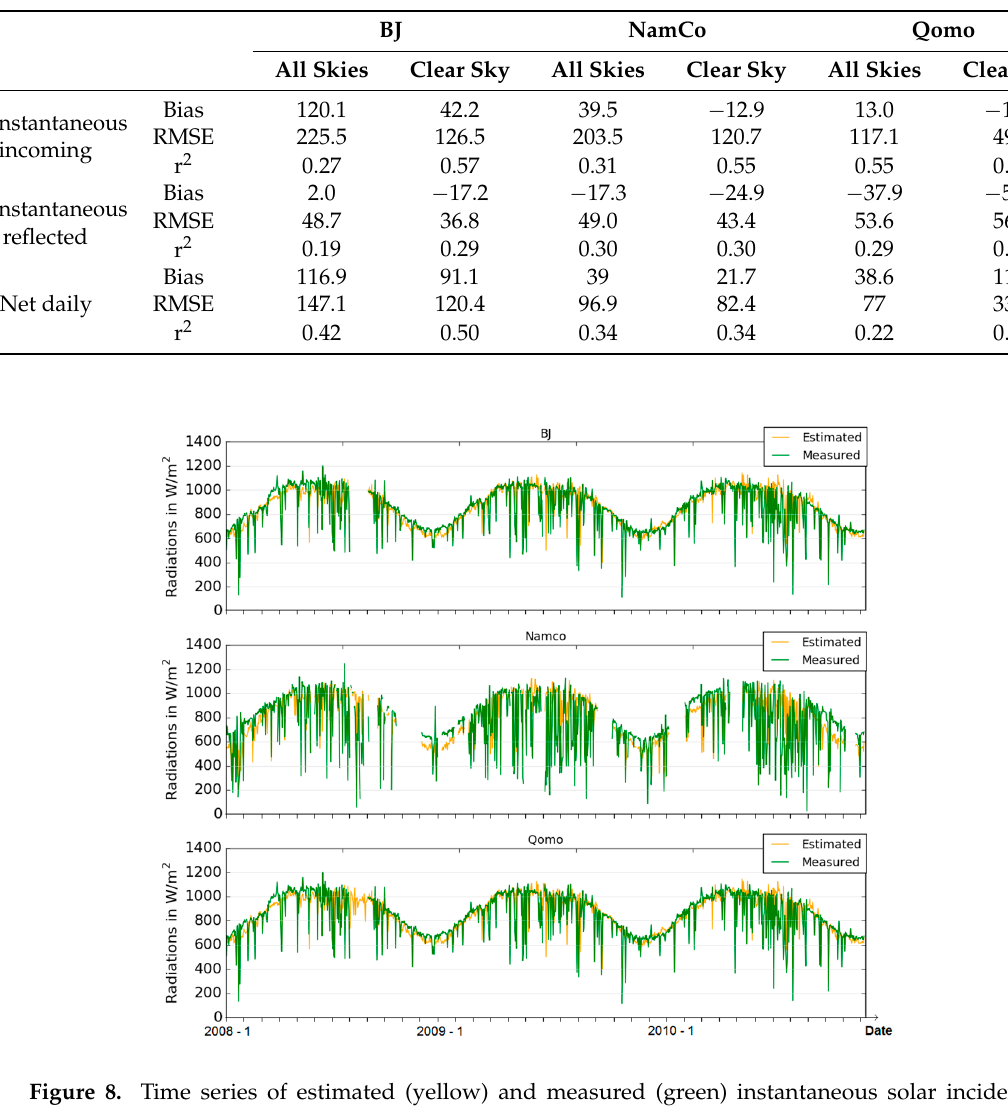
Table 4. Comparison of solar radiative fluxes estimated with and without topographic correction at Qomolangma station for the year 2009. The bias (W·m − 2 ), the RMSE (W·m − 2 ) and the r-square are provided for all skies and clear sky.